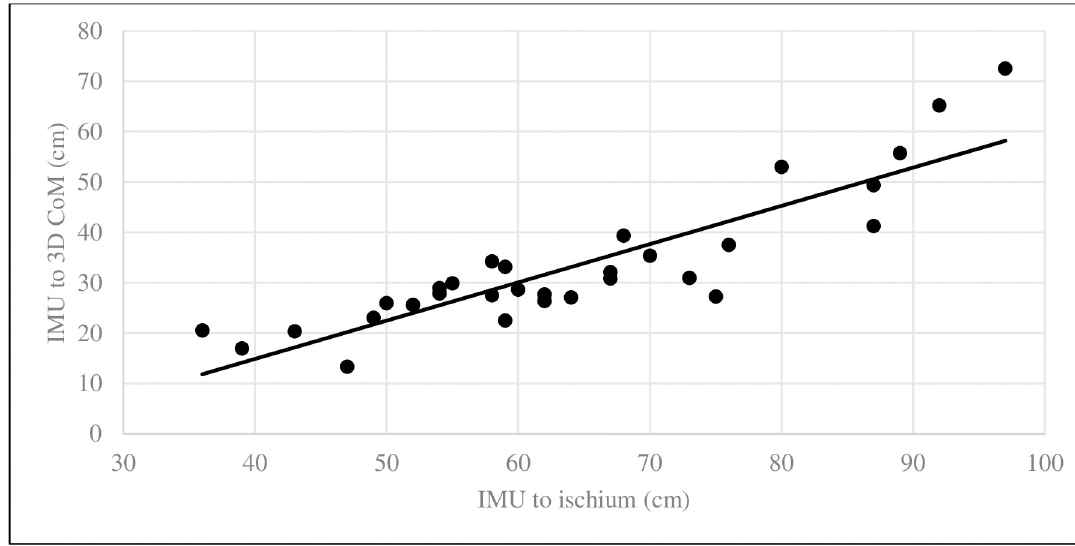
Fig 4. Linear regression between IMU location to subject ischium distance and IMU location to subject 3DCoM. This relationship had a R 2 = 0.78, p = 4.85 − 11 with normality of residuals (p = 0.91).